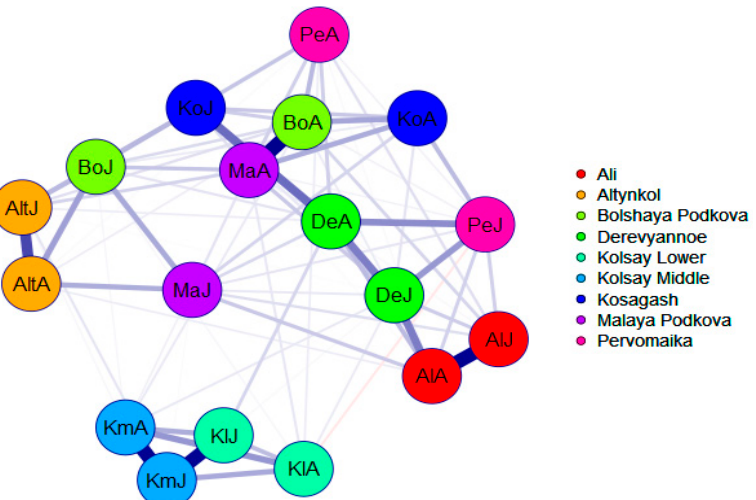
Figure 4. Zooplankton species similarity assessment according to the JASP network plot Abbreva-